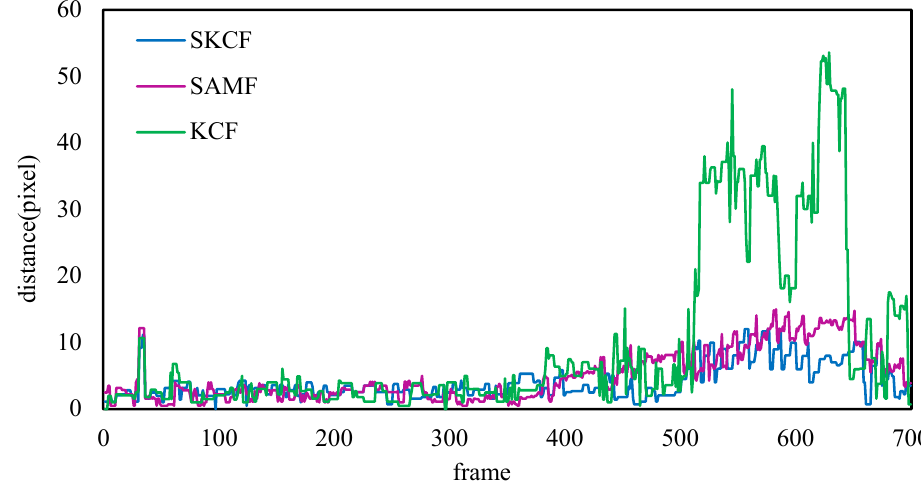
Figure 8. D2TGT curve distributions for the trackers on video #2.